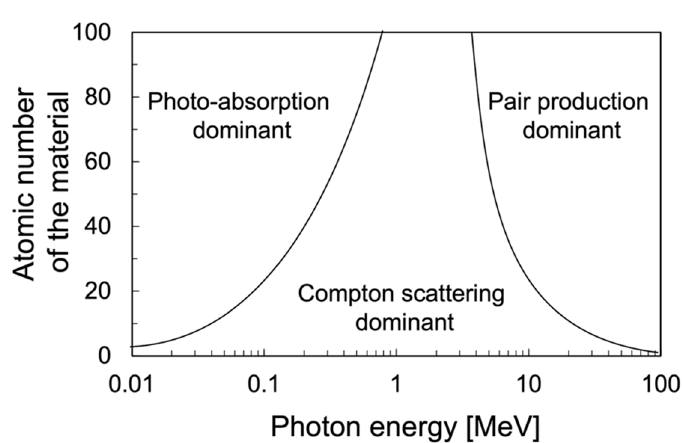
Figure 1. Energy at which photoelectric effect, Compton scattering, and pair production are dominant with respect to atomic number (Z) of the absorber.